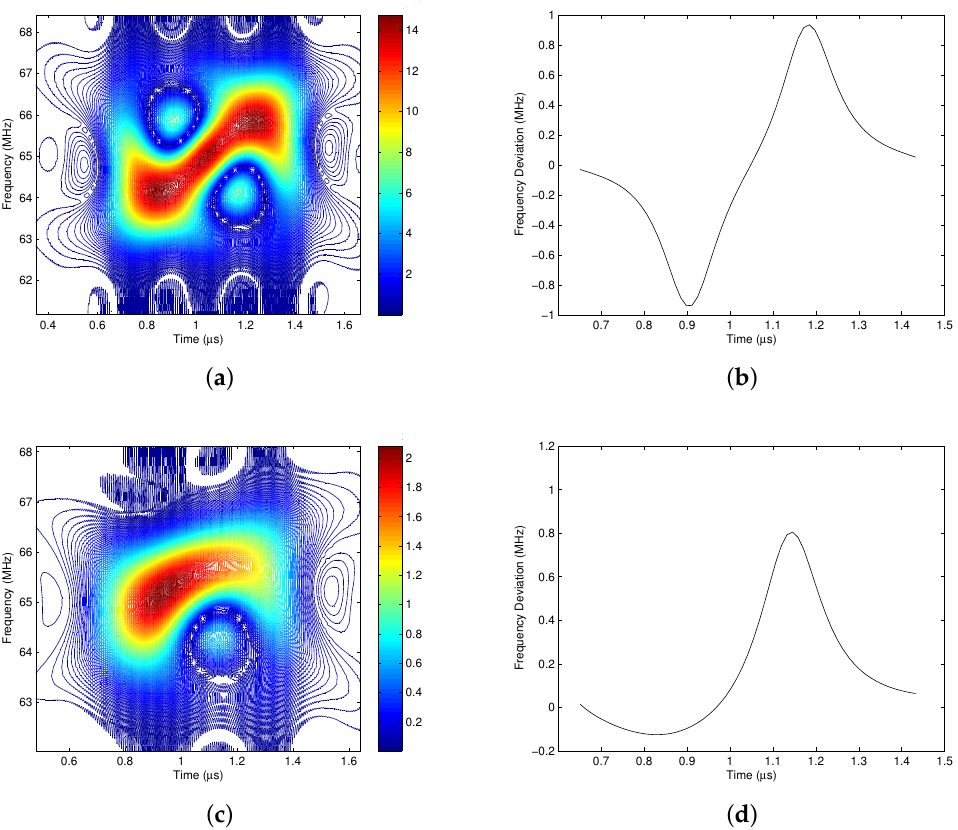
Figure 5. Time-frequency distribution and frequency deviation of 4-QAM modulated pulse shaping signals. ( a ) The time frequency distribution of {− 1 − i , − 1 + i , − 1 − i } ; ( b ) The frequency deviation of {− 1 − i , − 1 + i , − 1 − i } ; ( c ) The time frequency distribution of { 1 − i ,1 − i ,1 + i } ; ( d ) The frequency deviation of { 1 − i ,1 − i ,1 + i }